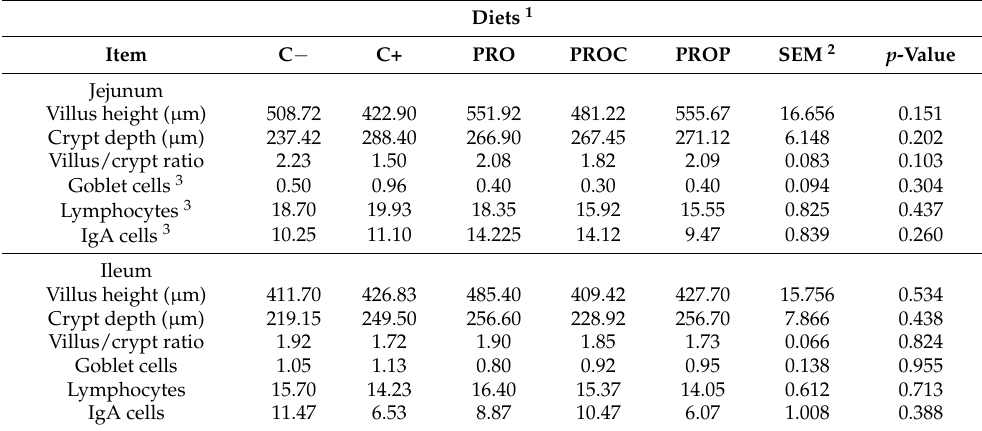
Table 5. Histomorphometrical and immunohistochemical intestinal parameters from piglets fed the experimental diets.